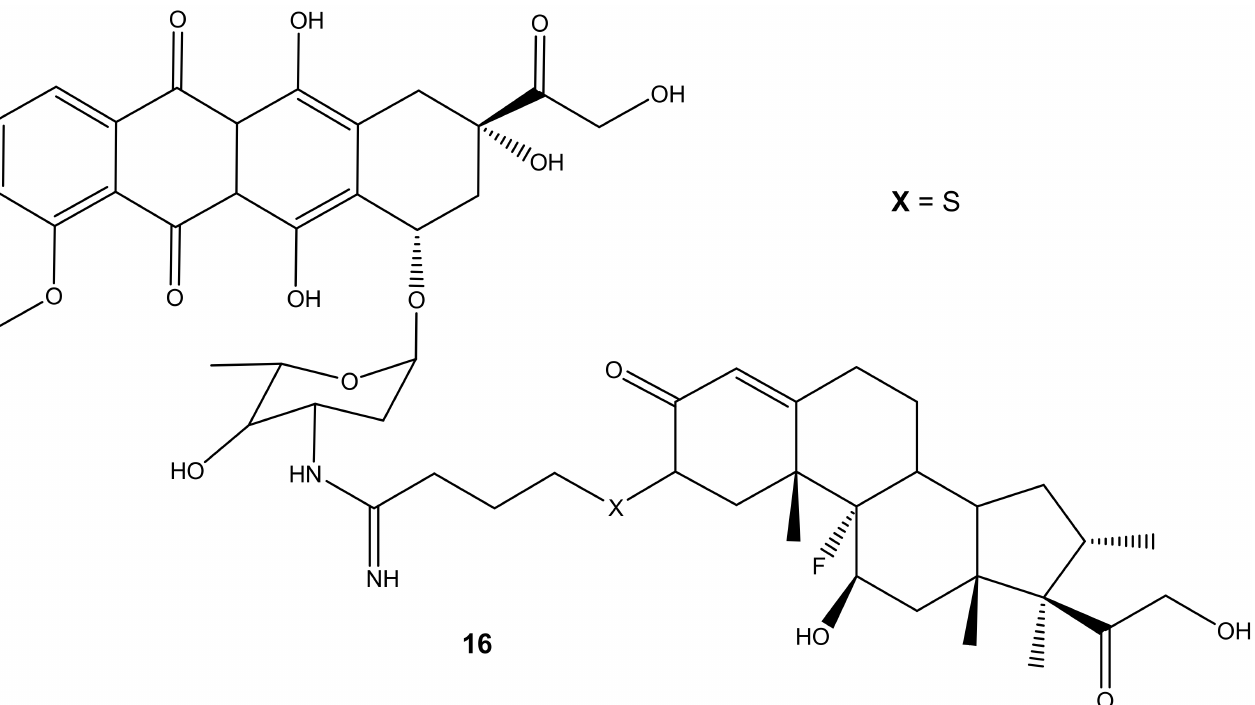
Figure 12. Chemical structure of dexamethasone-doxorubicin derivative synthesized via the amino group ( 16 ).